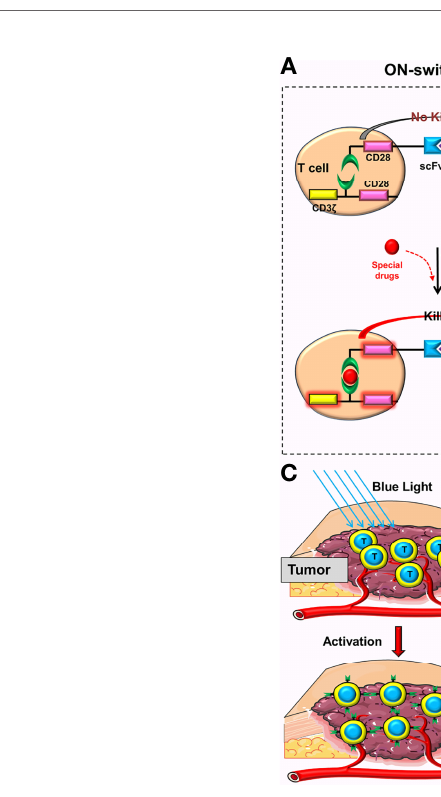
FIGURE 10 | Special CARs that can reduce toxic reactions. (A) Only when special drugs exist can the ON-switch CAR return to its complete state and be activated. When these drugs are removed, the ON-switch CAR will gradually return to the inactive state. (B) In the absence of lenalidomide, the OFF-switch CAR-T cell can be normally activated. In the presence of lenalidomide, the labeled CAR proteins will be degraded, preventing the CAR-T cell from recognizing the tumor cell. CAR proteins will gradually be generated after these drugs are removed. (C) These CAR genes can only be activated and translated into CAR proteins under the irradiation of blue